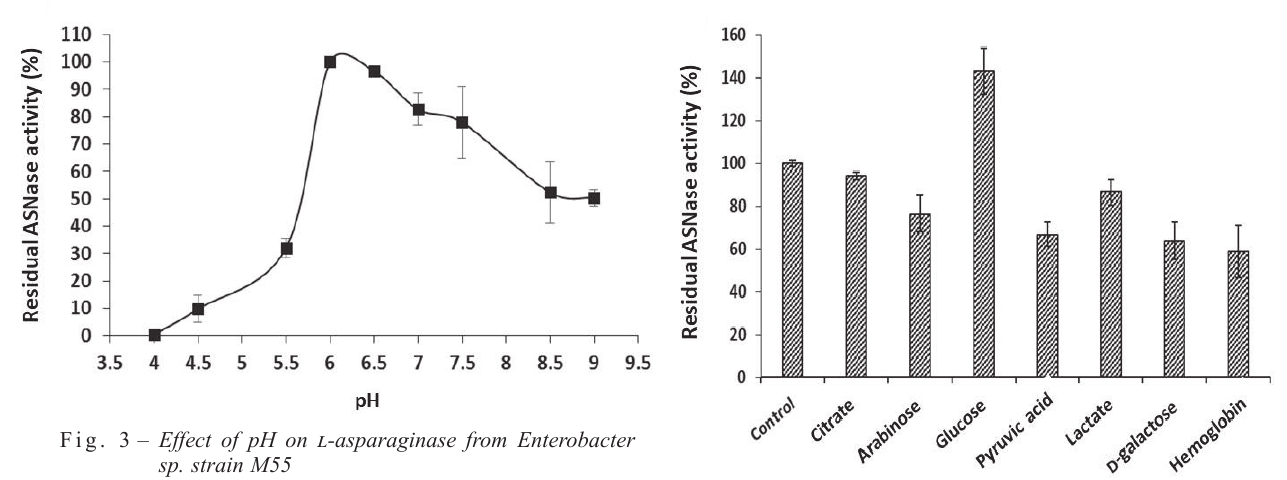
Fig. 6 – Effect of serum components on l -asparaginase from Enterobacter sp. strain M55